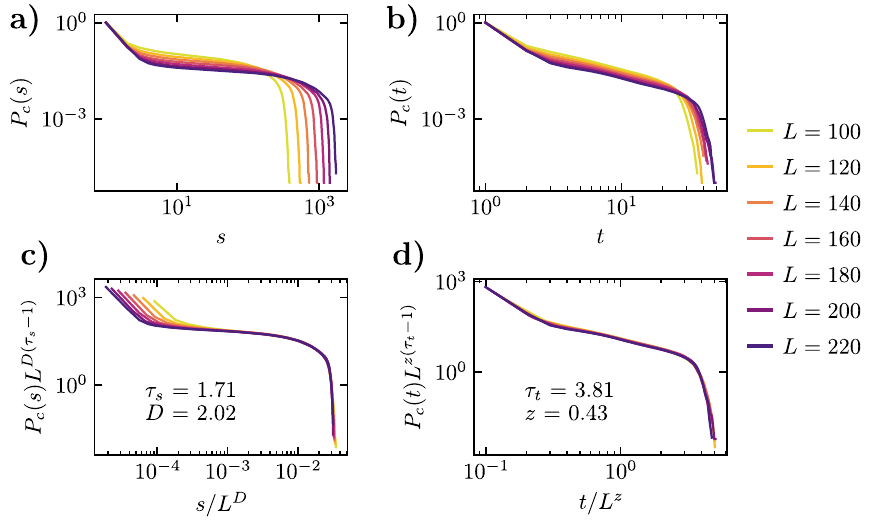
Figure 5. ( a ) Cumulative probability distribution of size P c ( s ) of avalanches induced by a perturbed leader in a system with η = 0.2 , turning threshold ϕ th (η) and different values of L . ( b ) Cumulative probability distribution of durations P c ( t ) of avalanches induced by a perturbed leader. ( c ) Check of the scaling of the cumulated size distribution as given by Eq. (5). ( d ) Check of the scaling of the cumulated time distribution as given by Eq. (5). Statistics are performed over at least 10 5 different